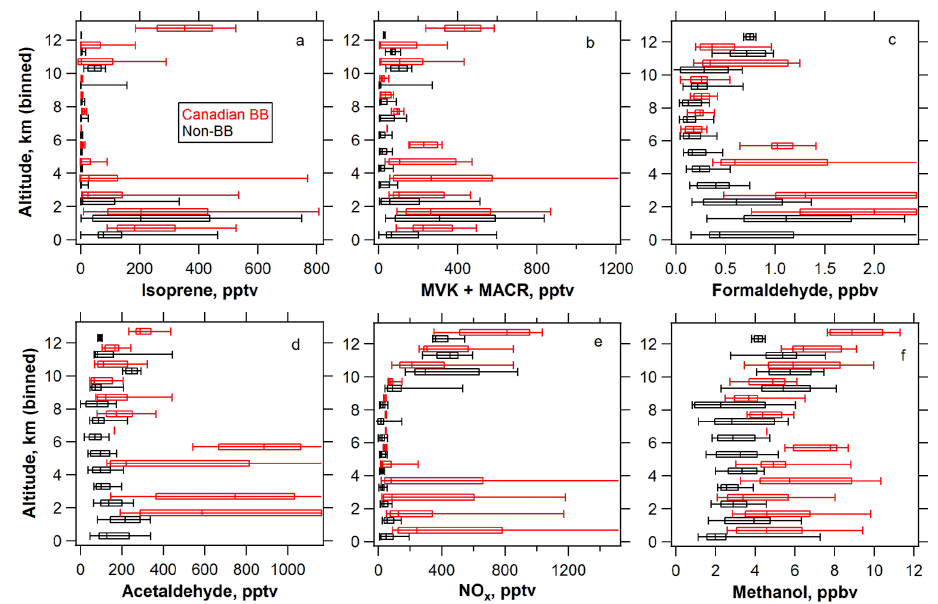
Fig. 2. Vertical profiles for select VOCs. Data are represented as box and whisker plots showing the median, lower quartile, upper quartile and the 10th and 90th percentiles of the recorded data. Data are binned in 1km increments. Plots in black are not influenced by biomass burning whereas red plots, which are slightly offset from the black plots for clarity, represent data that have a Canadian biomass burning signature.